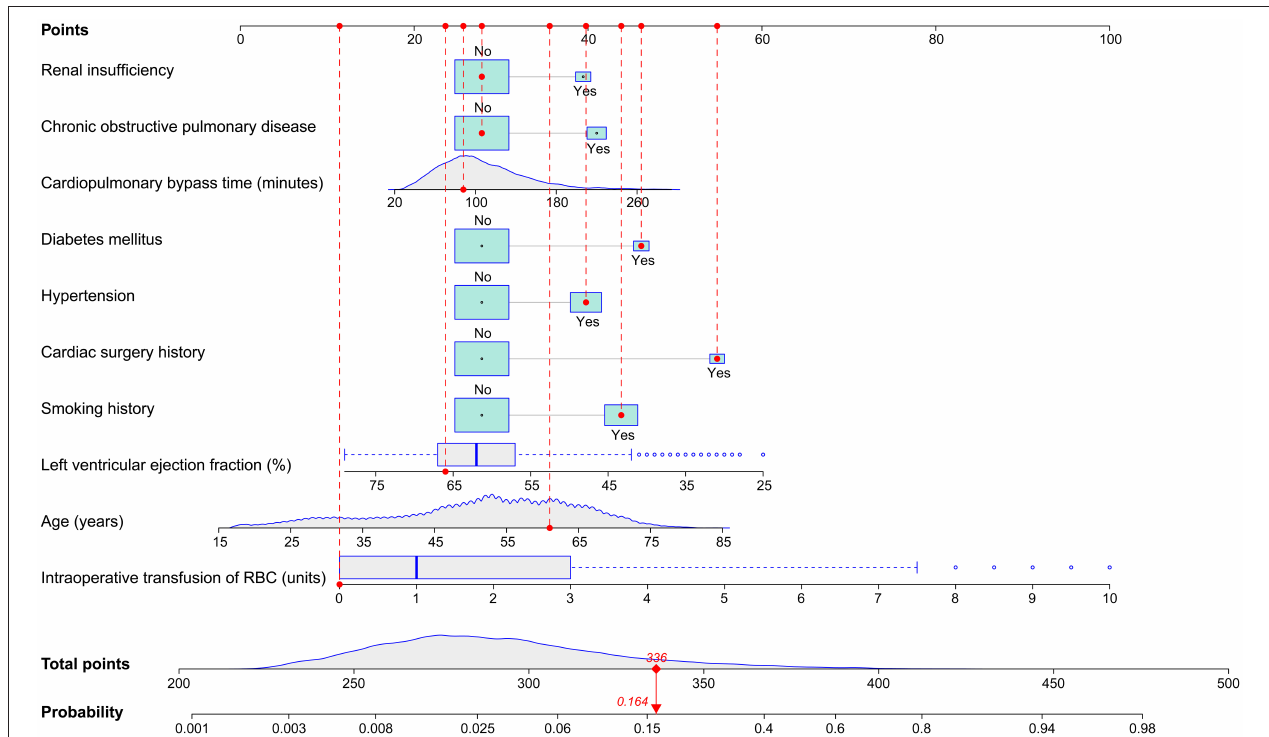
FIGURE 2 | Nomogram for the prediction of POP after ECS. A specific patient was shown to illustrate how to use the nomogram. This was a 61-year-old patient who had a smoking history, hypertension, diabetes mellitus, previous cardiac surgery, a left ventricular ejection fraction of 66%, a cardiopulmonary bypass time of 88min, without chronic obstructive pulmonary disease, renal insufficiency and RBC transfusion. The individual item score corresponding to each factor was presented at the top, and the total points were obtained from the sum of the scores corresponding to each factor by a red dot. Given values of the 10 predictors, the patient can be intuitively mapped onto the nomogram. It can be clearly seen from the nomogram that the total points of this patient was 336 points and the corresponding probability of POP was 0.164. ECS, elective cardiac surgery; POP, postoperative pneumonia; RBC, red blood